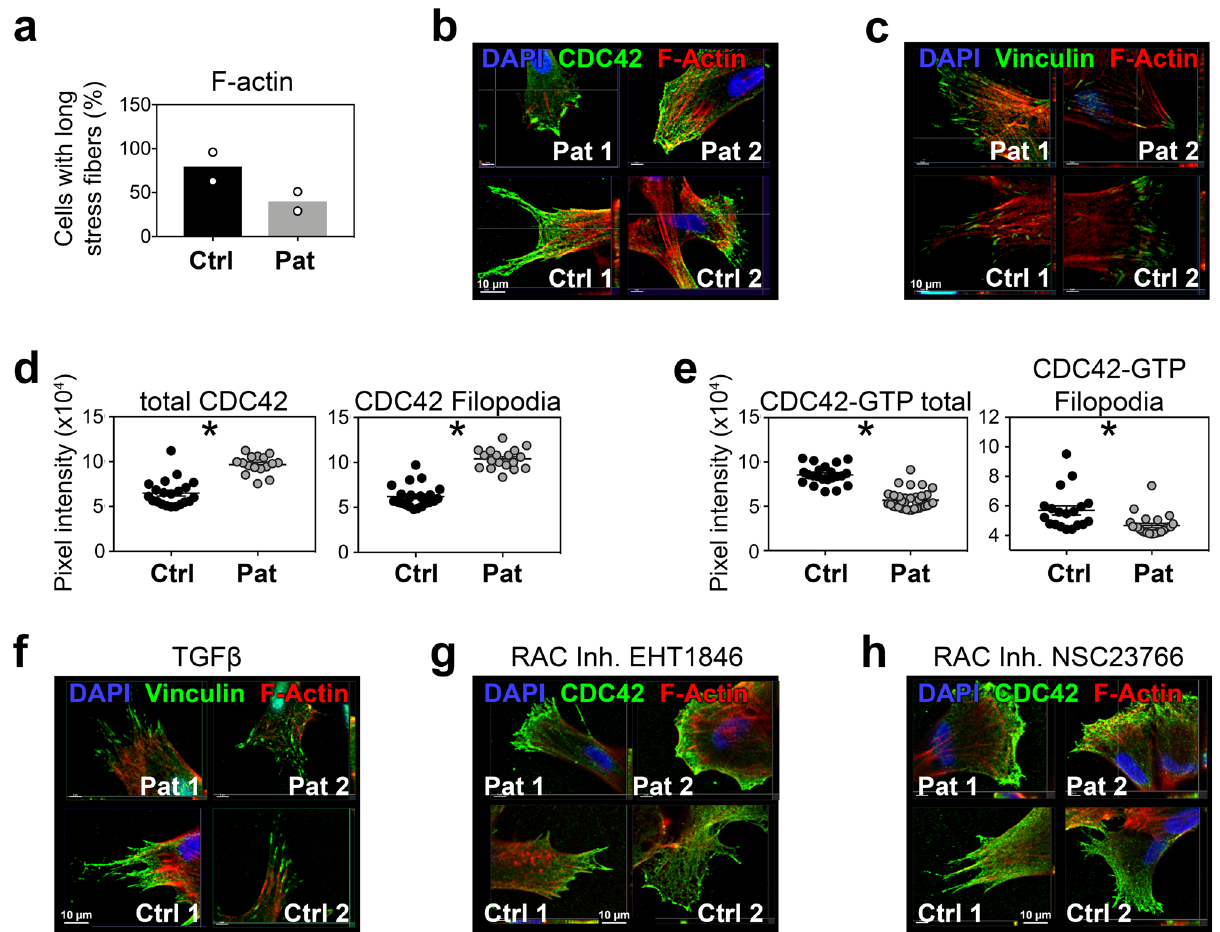
Fig. 4 Subcellular localization and modulation of F-actin and cytoskeletal proteins in control fi broblasts and DOCK2-de fi cient patient fi broblasts. a Skin fi broblasts from controls (Ctrl., n = 2) and DOCK2 -mutant patients (Pat., n = 2) were stained with phalloidin and the presence of long stress fi bers enumerated. Representative immuno fl uorescence shown by reviewer demand in supplementary Fig. 12. b Confocal microscopy of Ctrl. And Pat. Fibroblasts, stained for CDC42 (green) and phalloidin (red); nuclear counterstain DAPI (blue) or ( c ) for vinculin (green), phalloidin (red) and DAPI (blue). d Enumeration of total of green CDC42 pixels in Ctrl fi broblasts (black circles) and DOCK2 -mutant Pat. Fibroblasts in total cells (left graph, n = 21 control cells (obtained from 2 donors) and n = 16 patient cells (obtained from 2 donors), unpaired Mann – Whitney test, p < 0.0001) and fi lopodia (right graph, n = 23 control cells (obtained from 2 donors) and n = 18 patient cells (obtained from 2 donors), unpaired Mann – Whitney test, p < 0.0001). e Enumeration of the total of green CDC42-GTP pixels as in ( d ) for total cells (left graph, n = 35 control cells (obtained from 2 donors) and n = 54 patient cells (obtained from 2 donors), unpaired Mann – Whitney test, p < 0.0001) and fi lopodia (right graph, n = 19 control cells (obtained from 2 donors) and n = 24 patient cells (obtained from 2 donors), unpaired Mann – Whitney test, p = 0.0002). Confocal images of Ctrl or DOCK2 -mutant Pat. fi broblasts treated for 60 min in